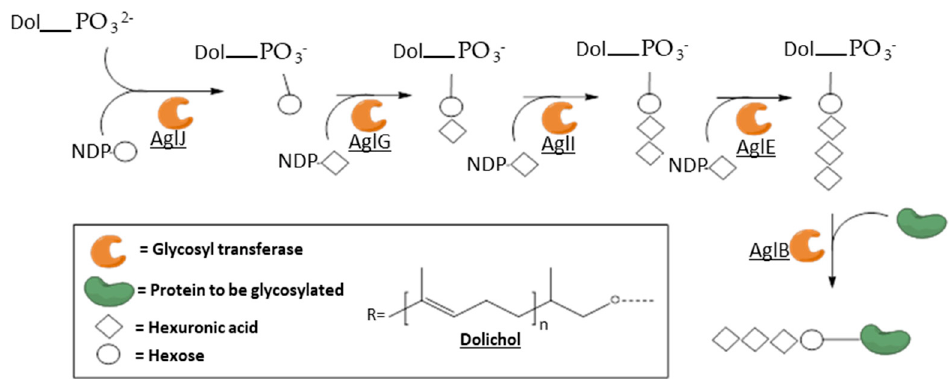
Figure 8. Simplified model of the N-glycosylation pathway in Haloferax volcanii , based on Jarrell et al. Some hexuronic residues are methylated and further elongations can occur after the transfer to the protein. AglJ is a dolichol phosphate hexose synthase; AglG, I and E are hexuronyl transferases; and AglB is an oligosaccharyl transferase [132].